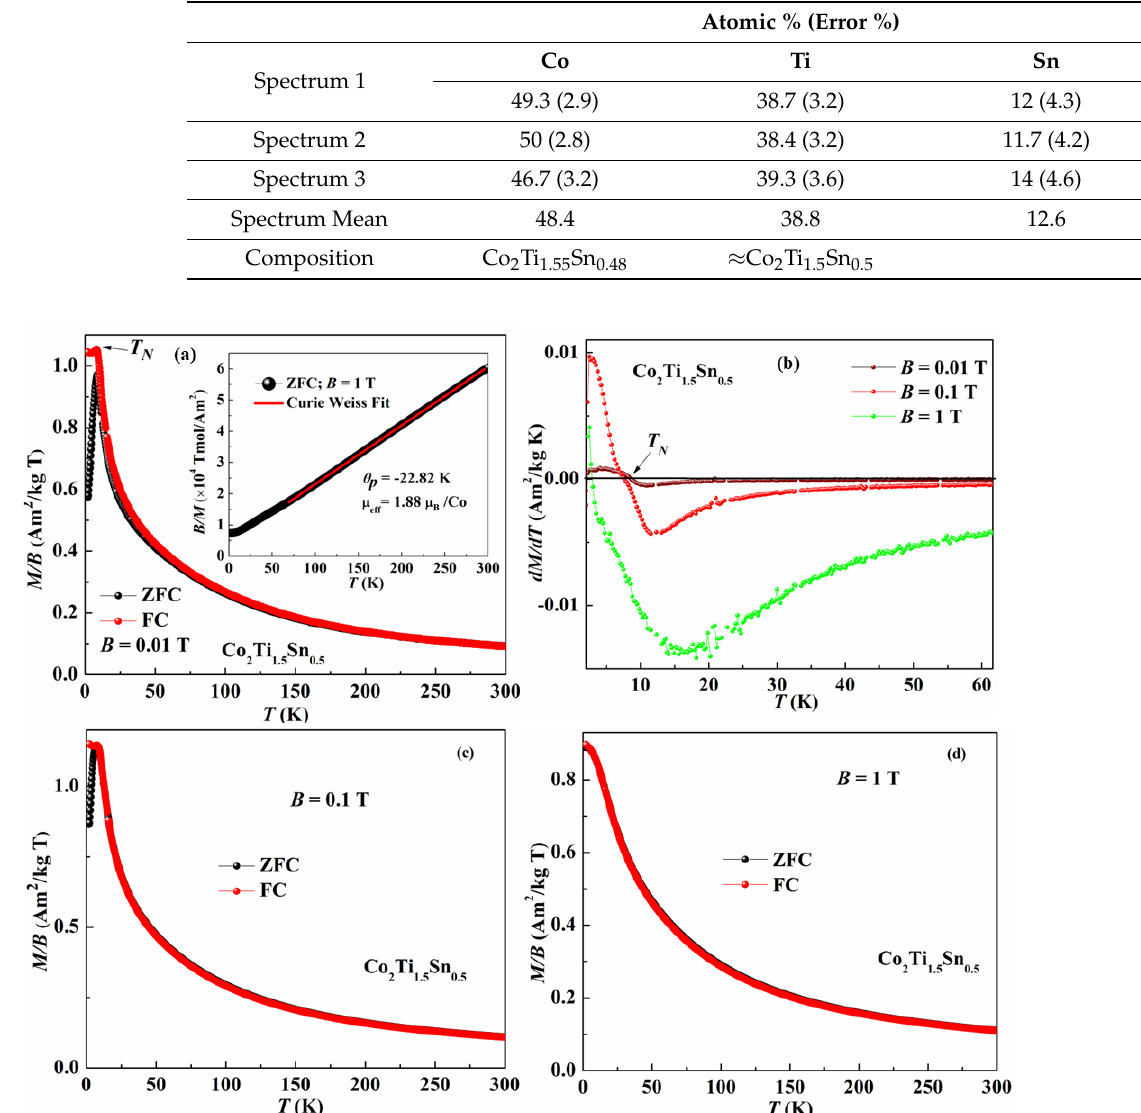
Curie – Weiss temperature and Curie constants are 𝜽 𝑷 = −𝟐𝟐. 𝟖 𝐊 and 0.8335, respec-